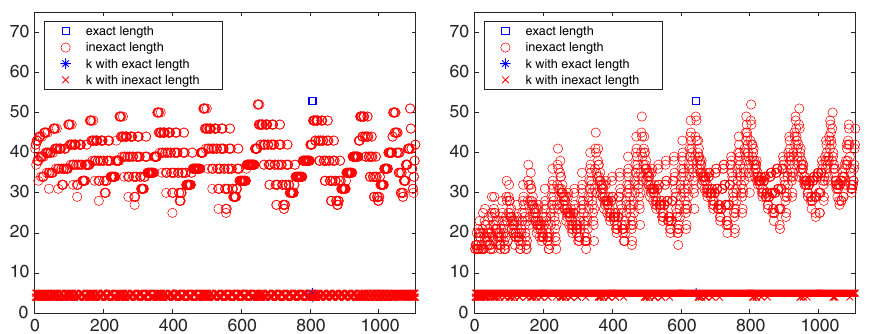
1.21.41.61.822.22.4